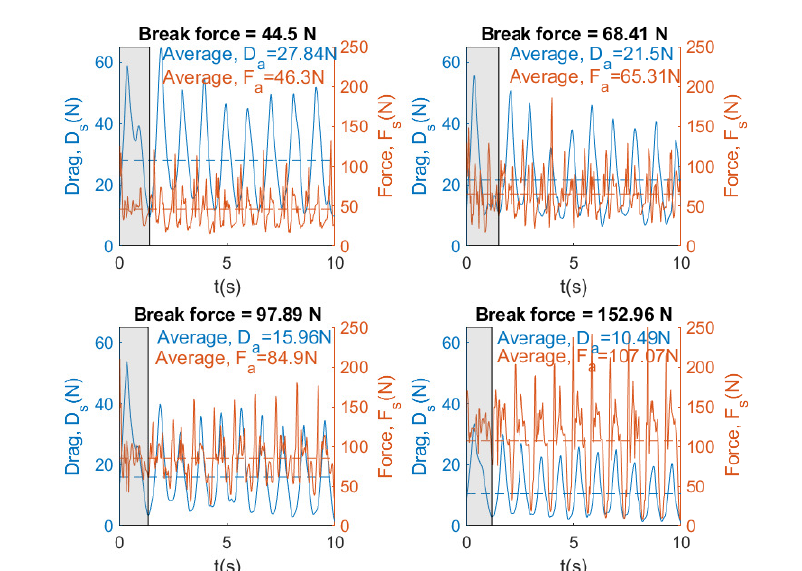
Figure 18. Instantaneous and average force and drag for swimming stroke breaststroke at different brake